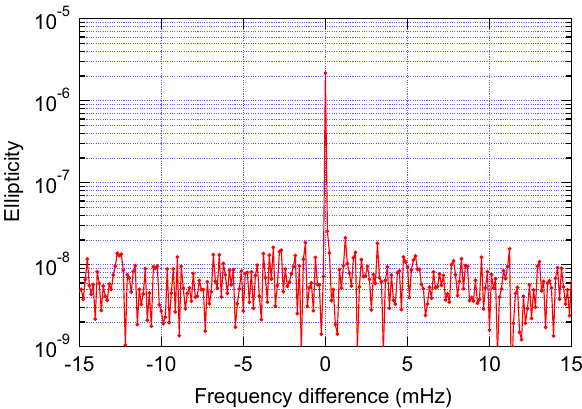
Fig. 13 Spurious ellipticity signal at 4 ν P = 42 Hz